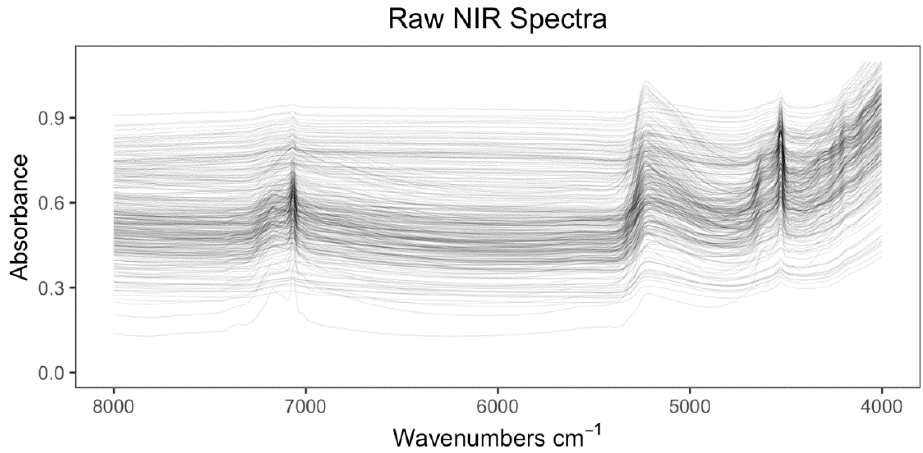
Figure 2. NIR raw spectral signatures for all soil samples.